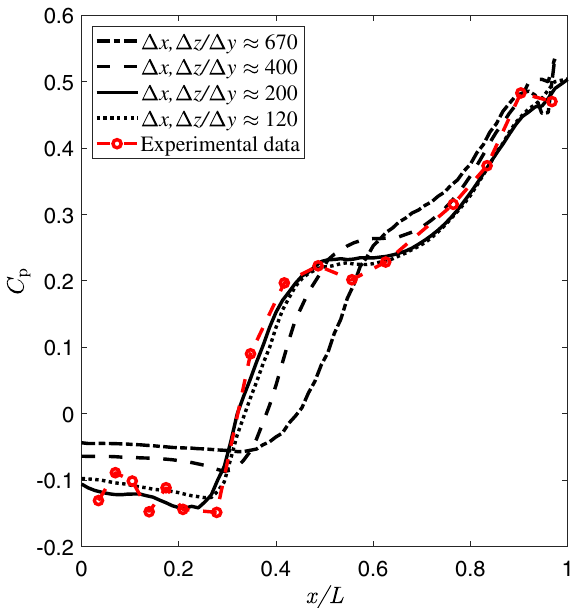
Fig. 2 Comparison of the cavity floor pressure distributions at M ¼ 0 : 2 from computational results using different meshes and experi- mental data [16]